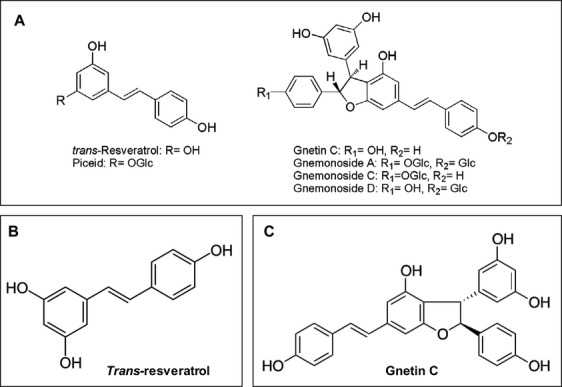
Chemical structures. (A) Stilbenoids from melinjo seeds. (B) Trans-resveratrol. (C) Gnetin C.